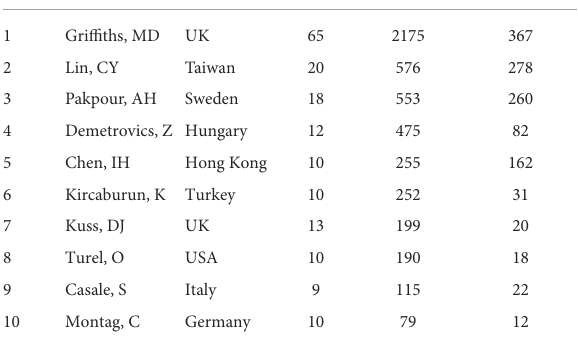
TABLE 1 Highly cited authors on social media addiction and problematic use ( n =